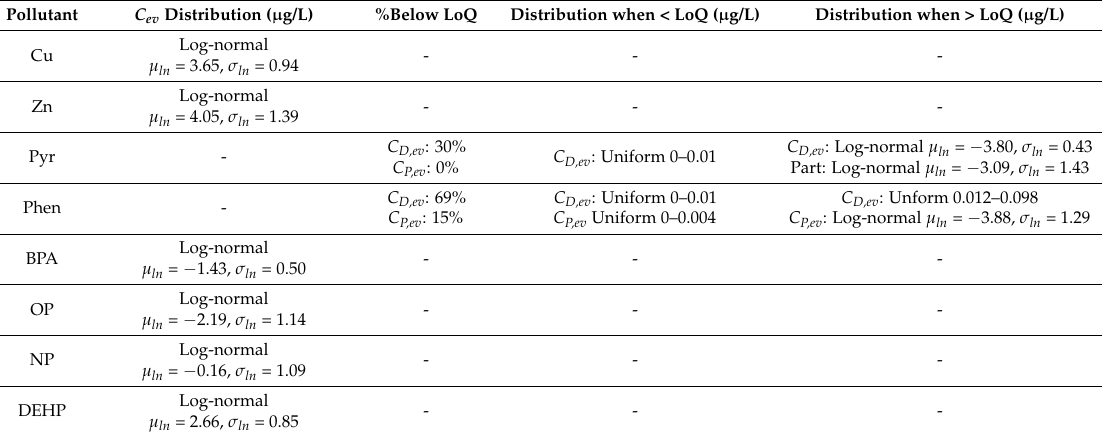
Table A4. Summary of event mean concentration ( C ev ), event mean dissolved concentration ( C D,ev ) and event mean particulate concentrations ( C P,ev ) distributions used to estimate concentrations in drained water for each